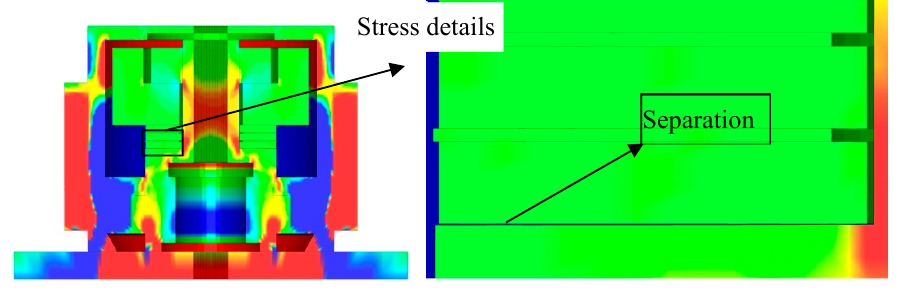
Figure 16. Separation caused by the temperature of 648 °C .